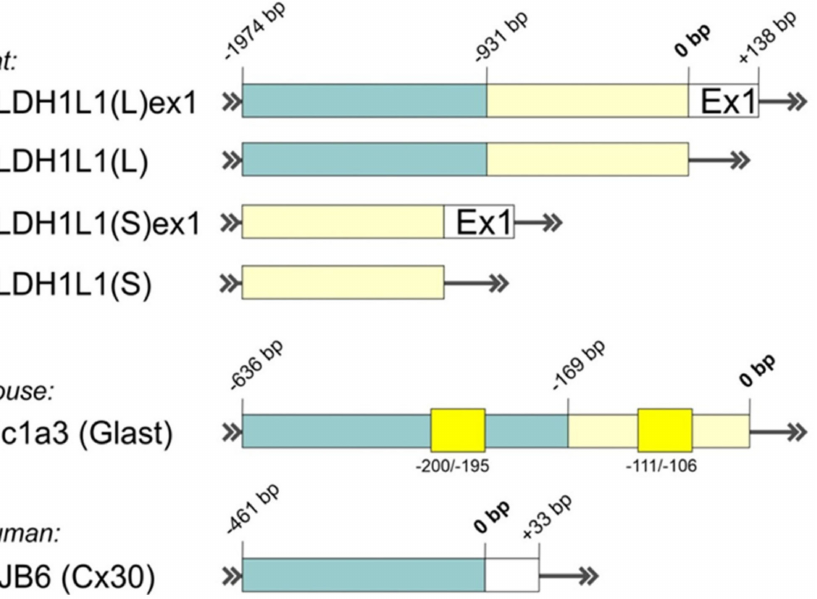
Figure 3. Schematic representation of putative promoter isoforms for astrocytic targeting constructed based on rat Aldh1l1 gene (for details, see [142]); mouse Slc1a3 gene (for details, see [148]), and human GJB6 gene (for details, see [[149]). Relative distances from the transcriptional start site (TSS) are provided in bp (base pairs). Arrows show the direction of transcription. Yellow boxes represent important regulatory regions. Ex1-the initial part of the first